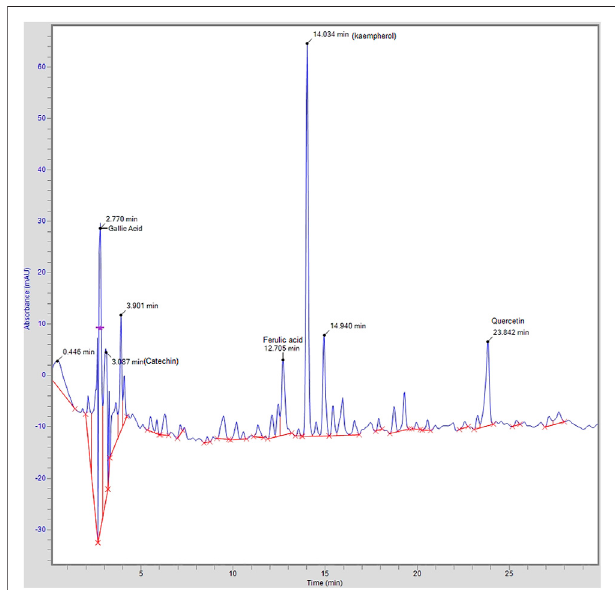
FIGURE 1 | HPLC chromatogram of aqueous ethanolic extract of A. of fi cinarum.